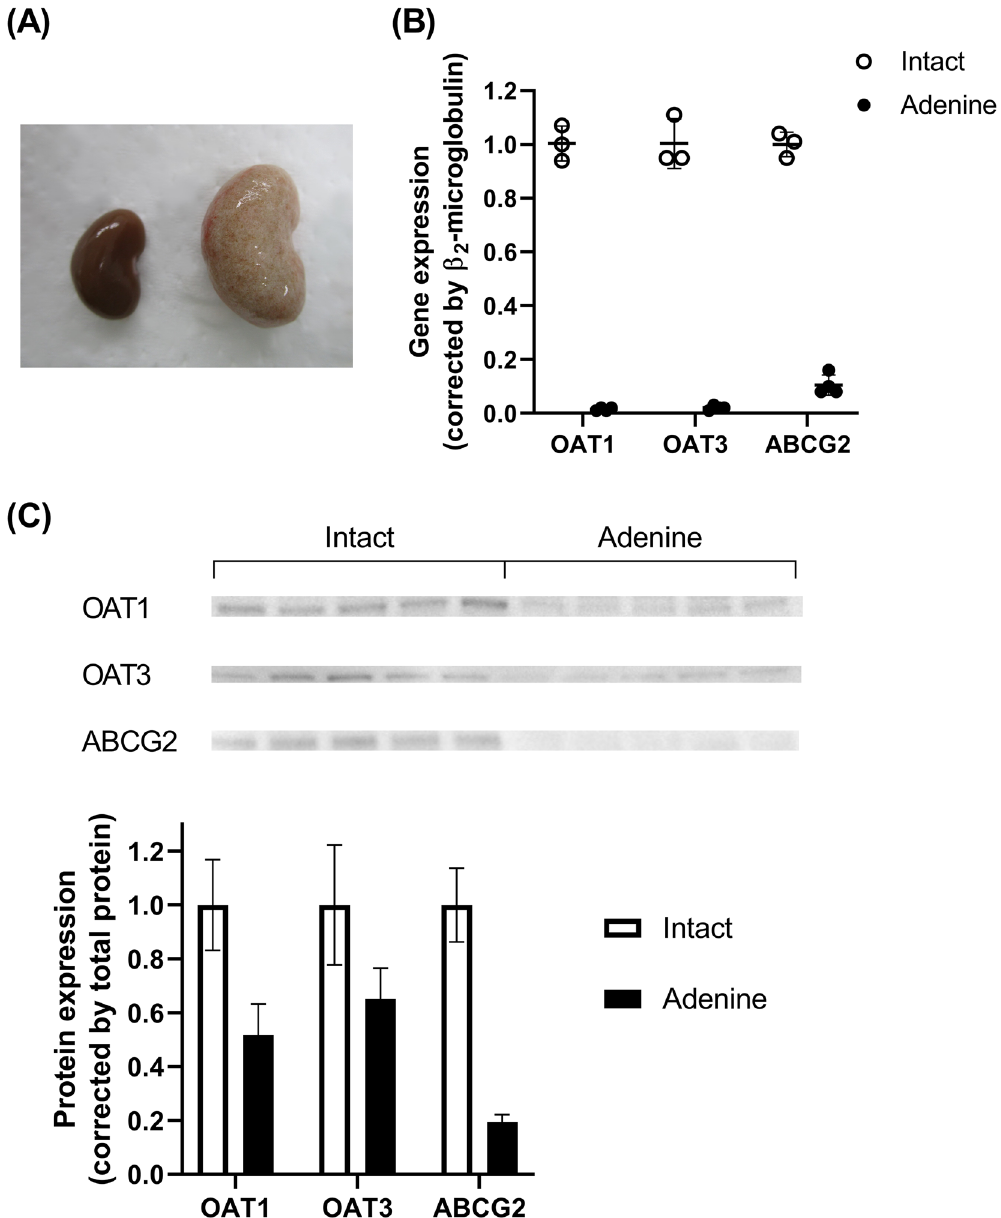
Figure 4. Photograph of the kidneys ( A ), renal expression of OAT1, OAT3, and ABCG2 mRNA ( B) , and protein ( C ) of intact and adenine-induced acute renal failure rats. The kidneys were obtained from Wistar rats fasted for 16 h. The total RNA and the total membrane protein were extracted from whole kidney. The PCR products of OAT1, OAT3, or ABCG2 gene were normalized to amplified β 2 -microglobulin, which was used as the internal reference gene. The chemiluminescence intensity of OAT1, OAT3, or ABCG2 bands in the PVDF membrane was normalized to that of the total protein. The expression of OAT1, OAT3, or ABCG2 in adenine- induced acute renal failure rats was compared with those in intact rats. Each value is presented as mean ± SD with ( B ) or without ( C ) individual dots of three to four animals. Each western blotting image ( C ) is cropped from full-length blots (Supplemental Fig. 1). ** P < 0.01, significantly different from the control group according to Student’s